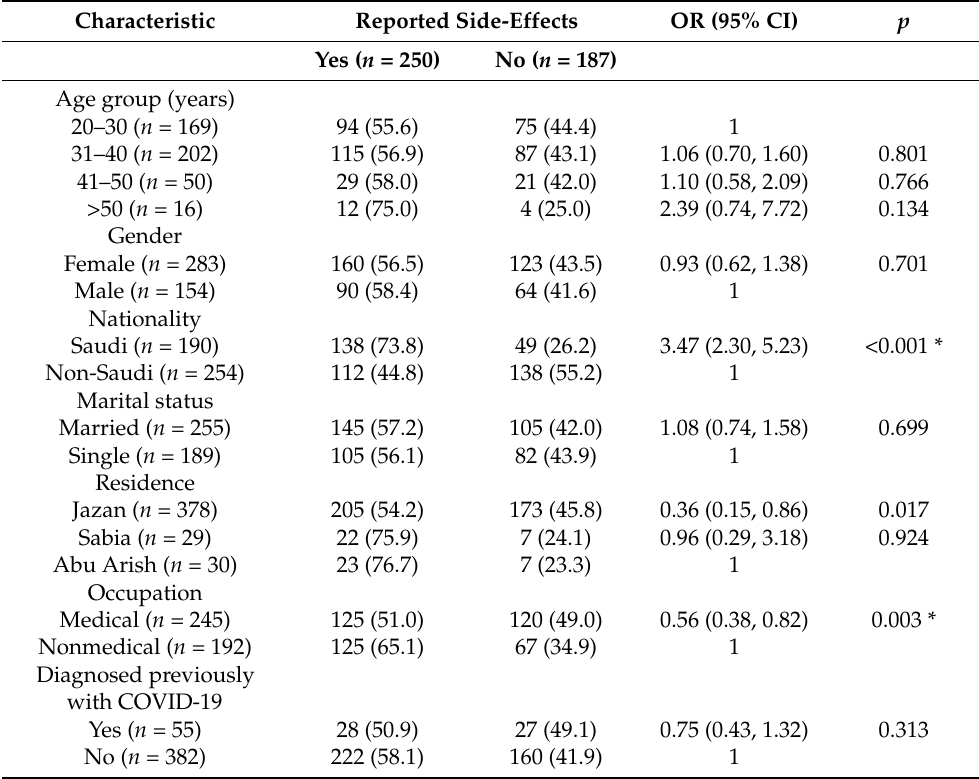
Table 3. Associations of the reported COVID-19 vaccine side-effects with the participants’ background characteristics ( n =